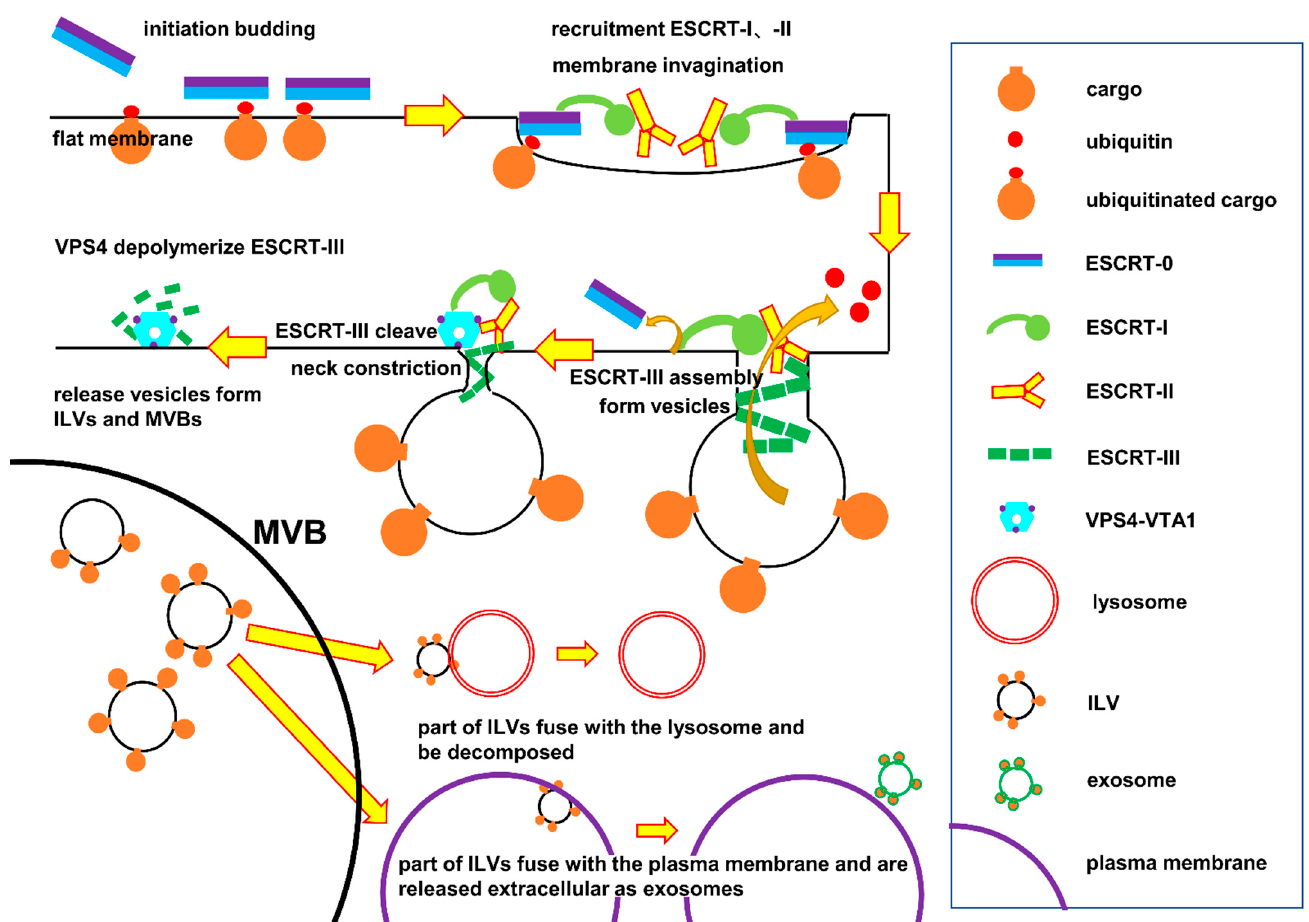
Figure 1. Structure of the ESCRT protein complex and its function in exosome biogenesis [24]. ESCRT-0 initiates the ESCRT pathway by recognizing ubiquitinated cargo and binding to the endosomal membrane. After ESCRT-0 recruits ESCRT-I, ESCRT-I and -II interact with each other and function to invaginate endosome membrane to form initial buds and combine with ubiquitinated cargo to form a cargo-rich area. Then, ESCRT-III is assembly in the neck of the bud. After isolating and classifying ESCRT-I, ESCRT-III drives the budding of vesicles, which are decomposed by the VPS4-VTAL complex.